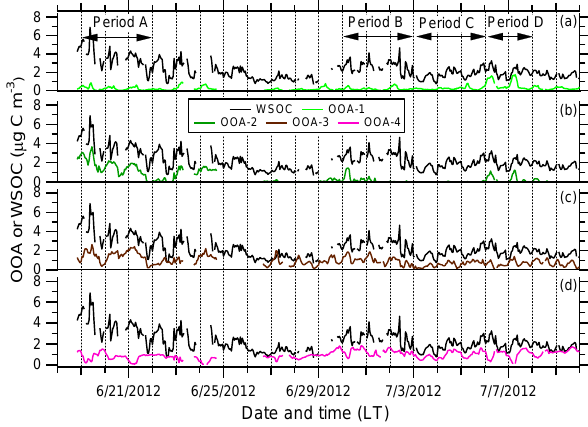
Figure 9. Time series of hourly averaged WSOC with AMS ME- 2 factors (a) OOA-1, (b) OOA-2, (c) OOA-3, and (d) OOA-4 at SPC. The units for each factor have been converted from µgm − 3 to µgCm − 3 using their calculated OM / OC ratio (OOA-1 = 1.81, OOA-2 = 2.15, OOA-3 = 2.13, and OOA-4 = 1.62). The dashed vertical lines indicate midnight local time (UTC + 2). Periods A, B, C, and D are also